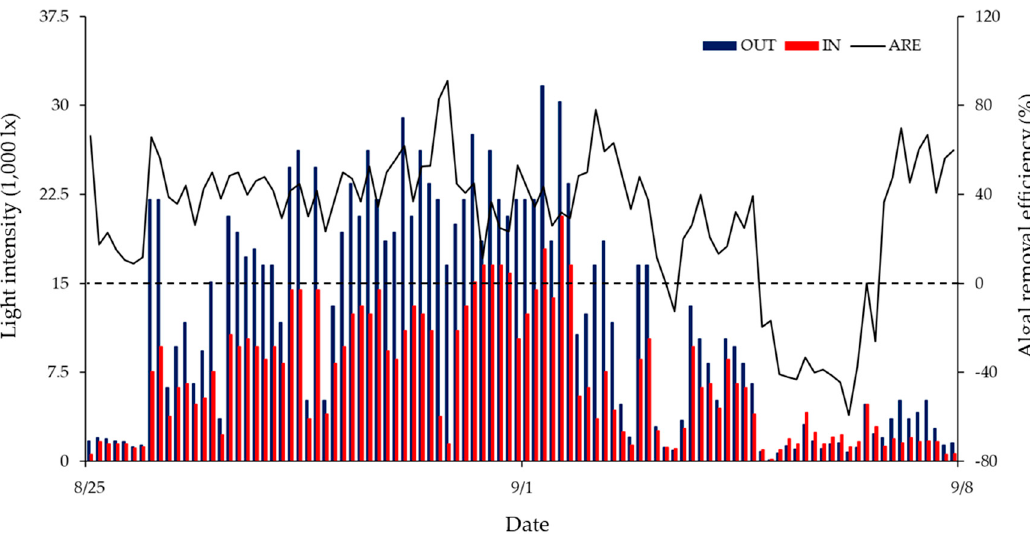
Figure 7. Daily variation in light intensity at a 1 m depth on both sides (IN and OUT) of the alternative algae-blocking mat (ABM) from 25 August to 8 September 2015. Biofilm formation was detected by light intensity. The single dotted line indicates a reference point (0%) of the algal removal efficiency.